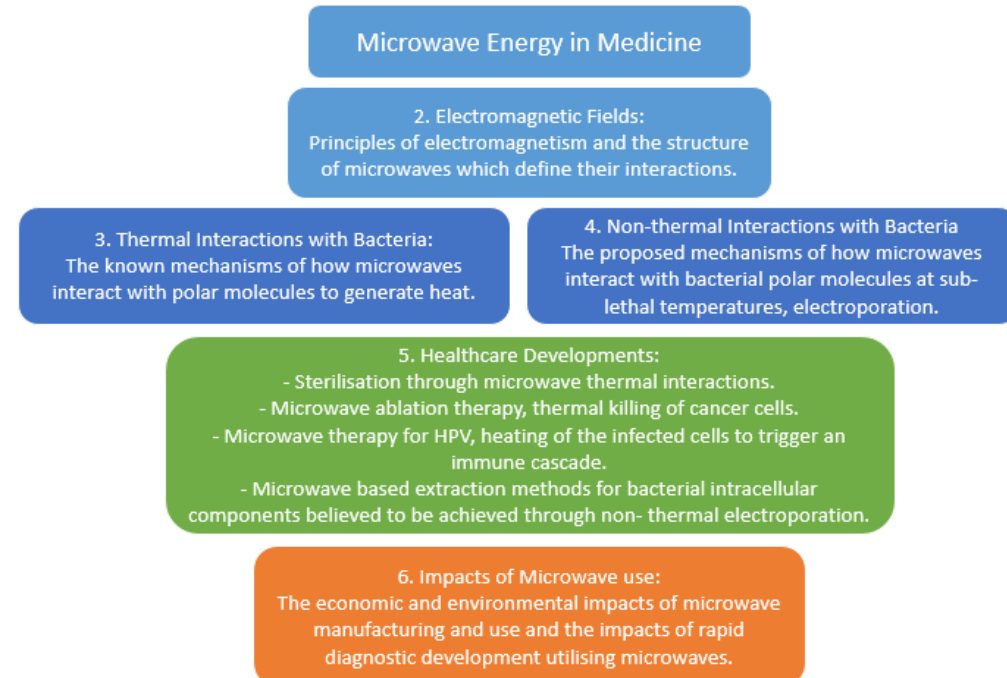
Figure 2. Summary of topics covered within microwave energy in medicine. Diagram depicts key themes described in this review.